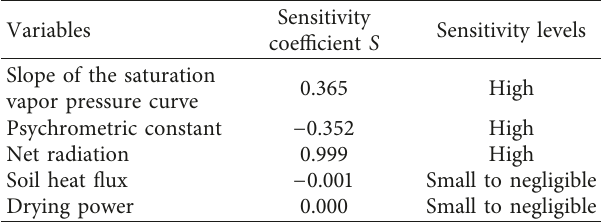
Table 5: Sensitivity of actual evapotranspiration to other